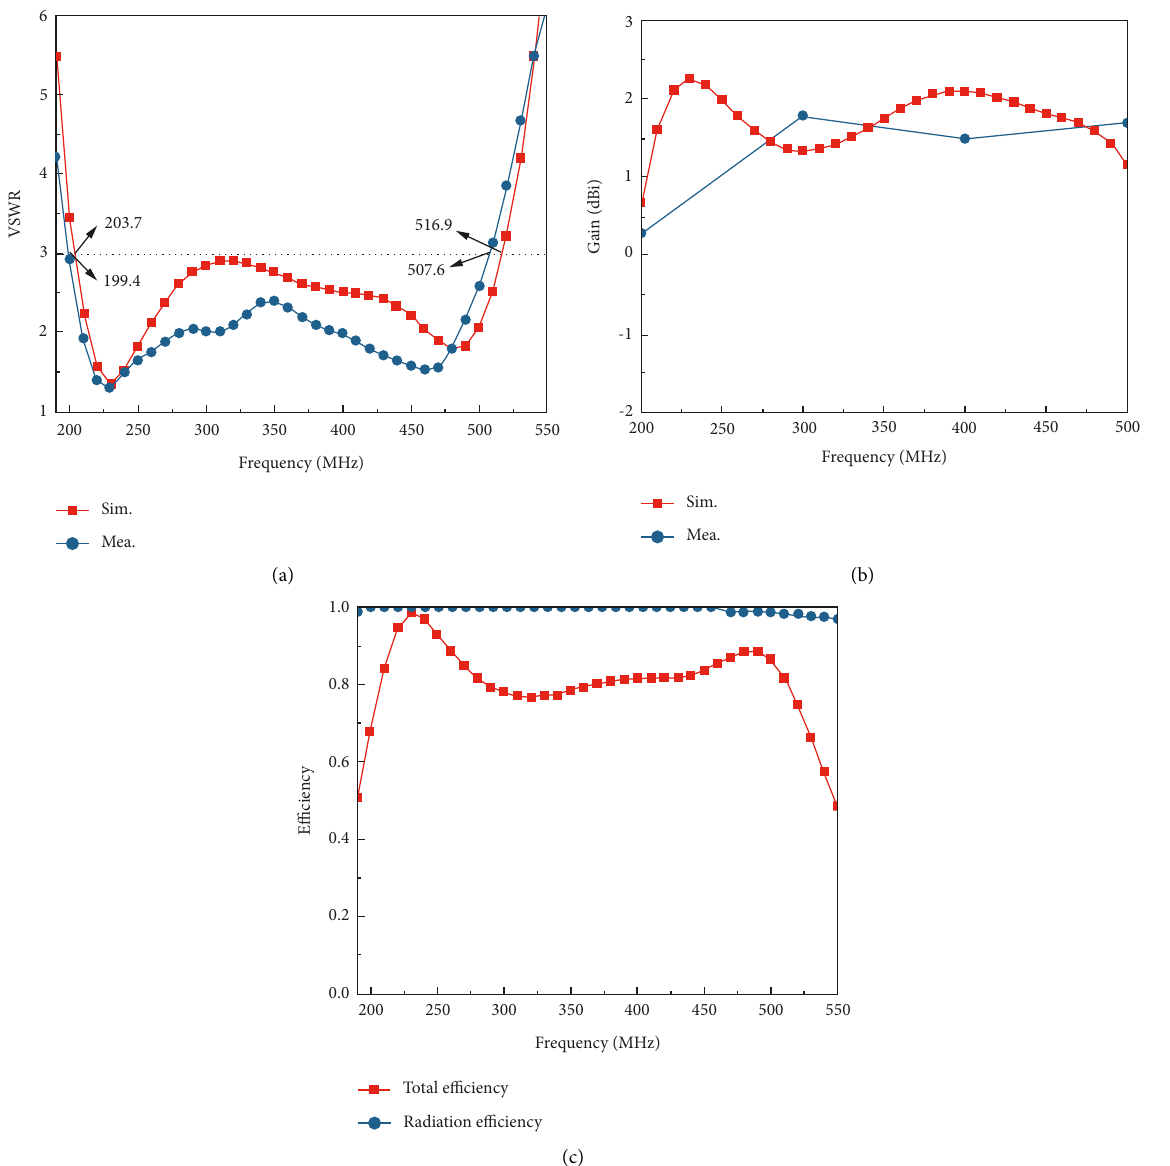
Figure 18: Simulated and measured (a) VSWR, (b) gain, and (c) simulated efficiency results (by CST 2018